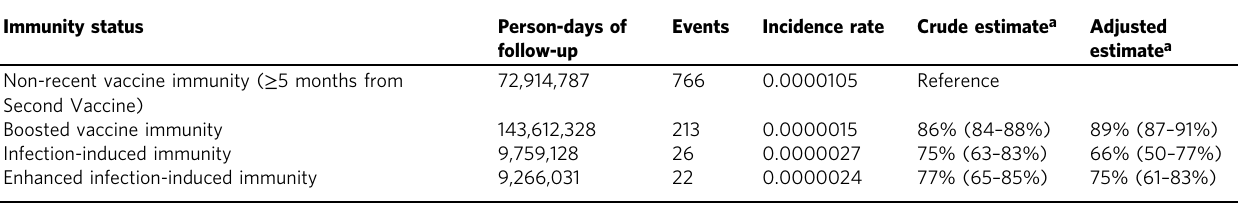
Table 2 Estimated crude and adjusted incidence rate reduction of covid-19-related hospitalization for each